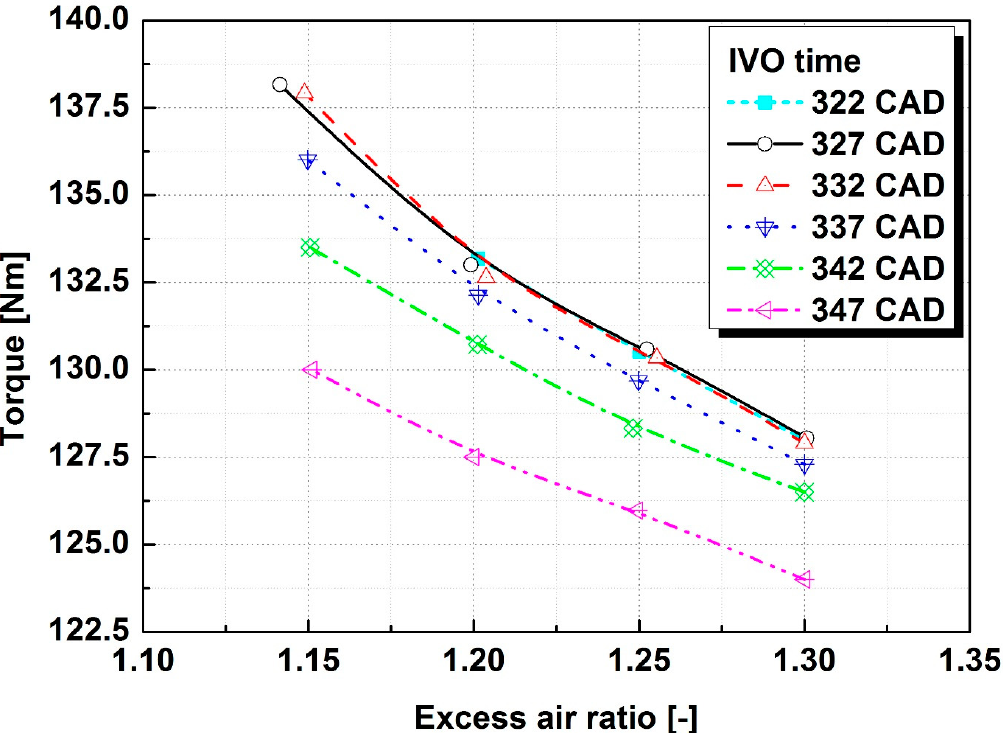
Figure 8. Torque changes with intake valve opening time and excess air ratio changes at constant exhaust valve opening time of 161 crank angle degree after top dead center (CAD ATDC).